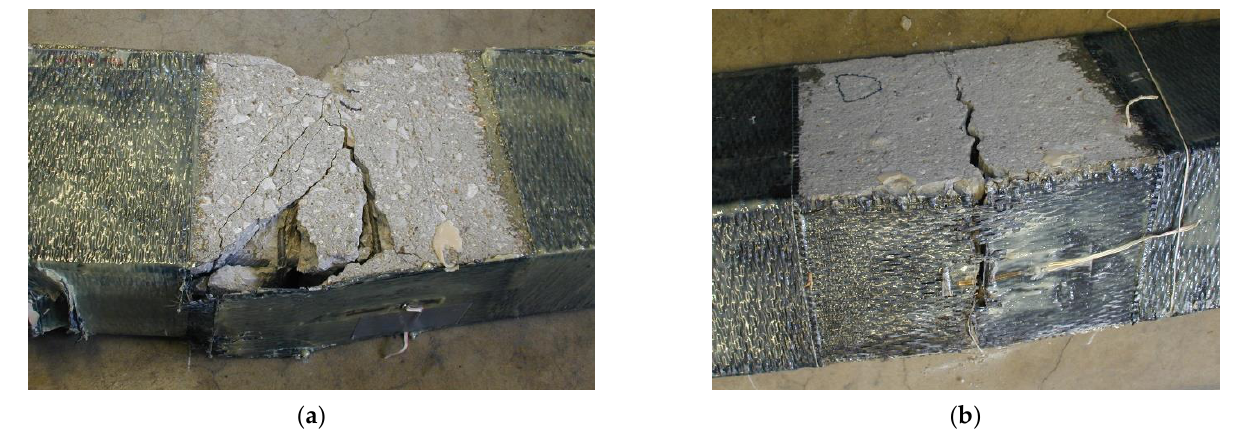
Figure 7. Observed failure modes of strengthened beams: ( a ) specimen ES1 (CFRP bonded without cyclic loading); ( b ) specimen ES2 (CFRP bonded during cyclic loading).